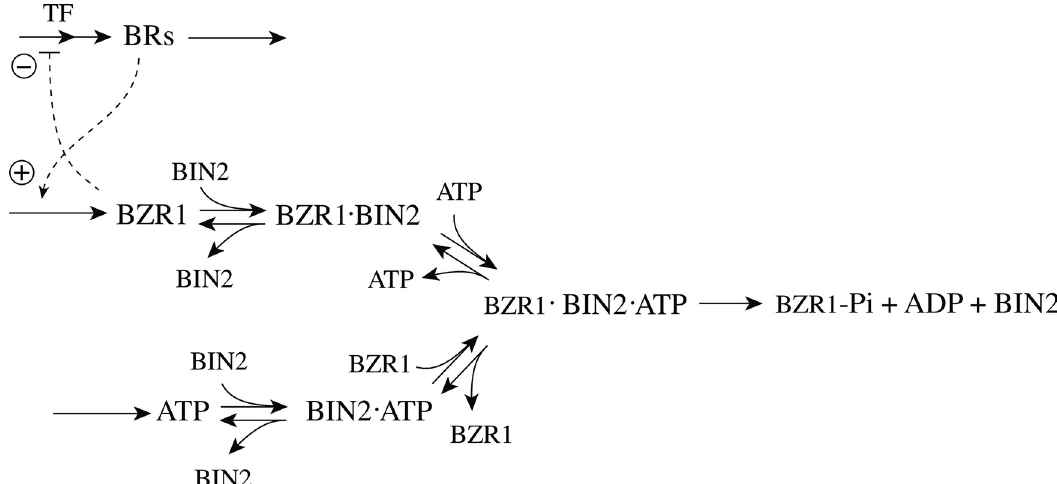
Fig 65. M2 dual-E control loop of Brassinosteroid homeostasis. Brassinosteroid genes are transcribed where TF indicate a set of transcription factors. When BRs bind to their receptors unphosphorylated BZ1 is produced which binds to the transcription factor and thereby inhibits Brassinosteroid transcription. The GSK3-like kinase BIN2 phosphorylates BZR1 and removes it from the negative feedback loop. Phosphorylated BZR1 is finally degraded by the proteasome.